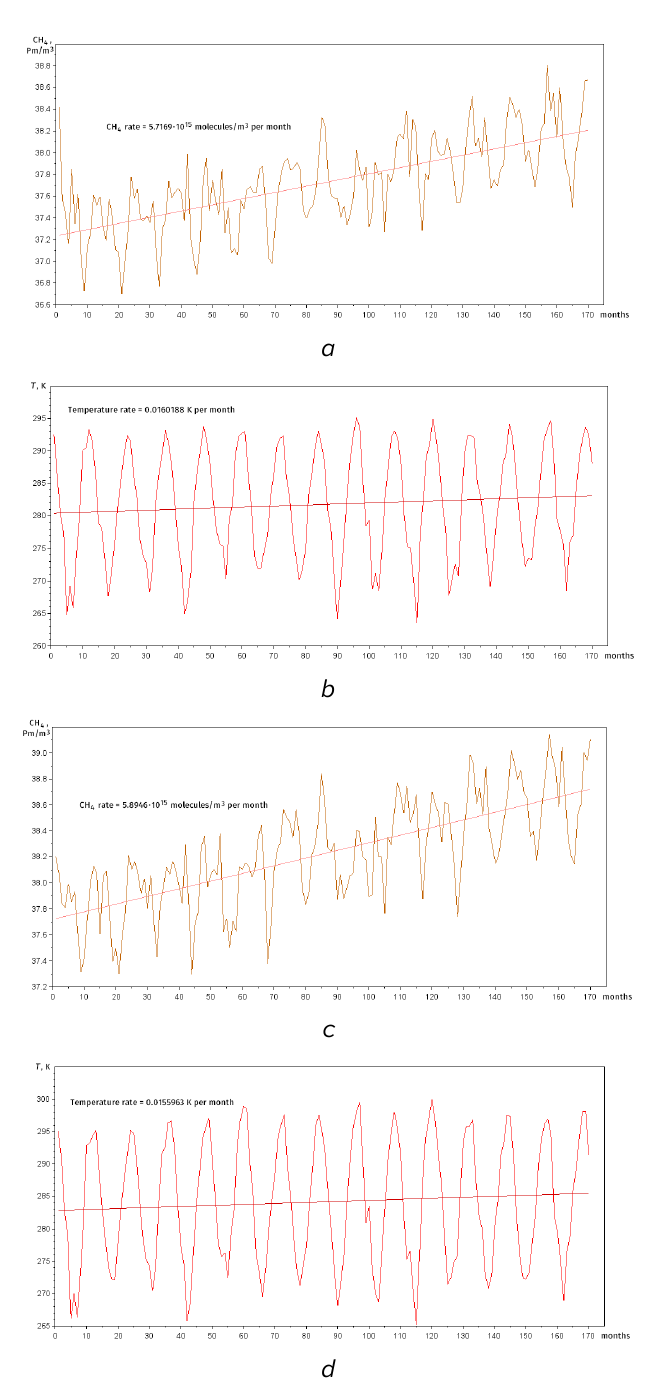
Figure 3. Obtained time series of methane atmospheric concentration ( a , c ) and near-ground temperature ( b , d ) over Polesie ( a , b ) and Steppe ( c , d ) physiographic regions of